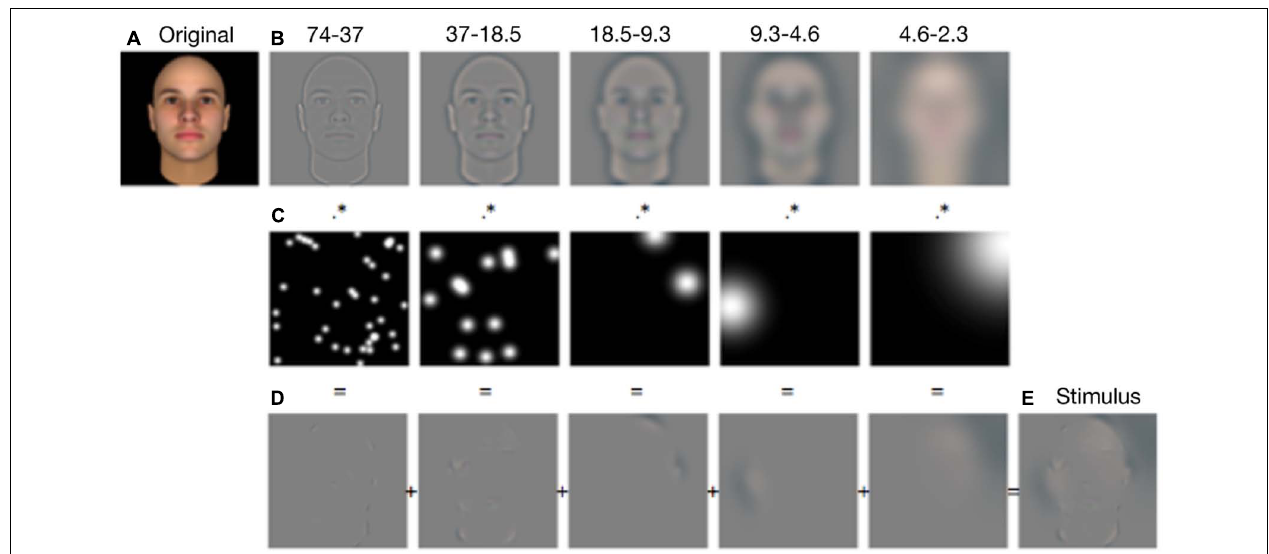
FIGURE 1 | Illustration of the stimulus-generation process for Experiment 1. Each original stimulus (A) was first decomposed into five spatial-frequency bandwidths (B) . Each bandwidth was then independently